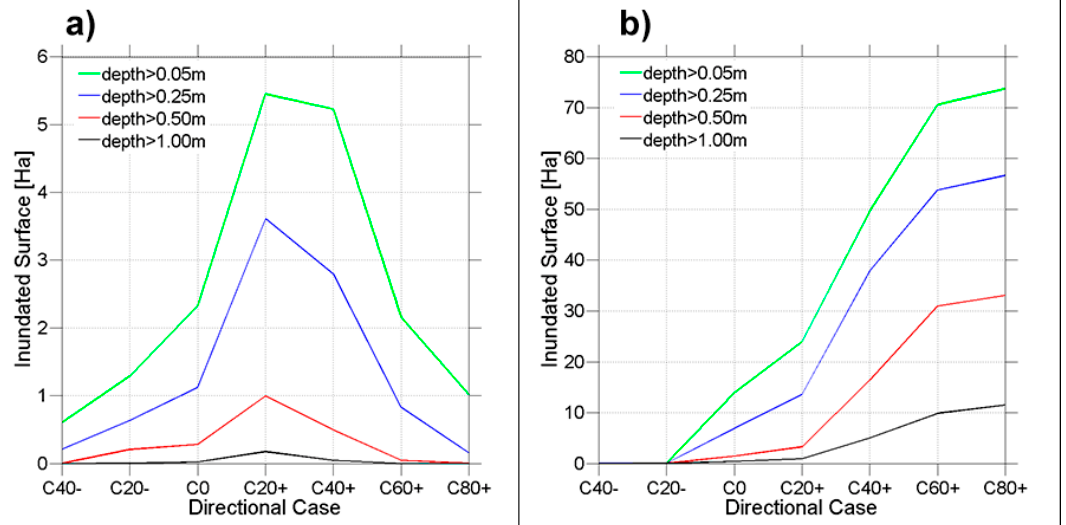
Figure 9. Variation of simulated inundated surface for different inundation depths as a function of the simulated storm direction for the northern ( a ) and southern ( b ) control areas (see Figure 4 or 8 for location).